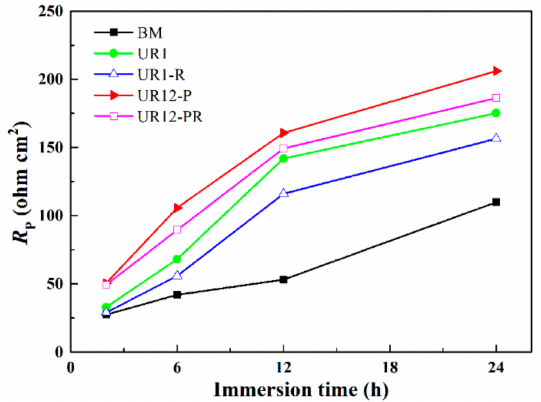
Figure 13. Dependence of the polarization resistance on time in the test solution at